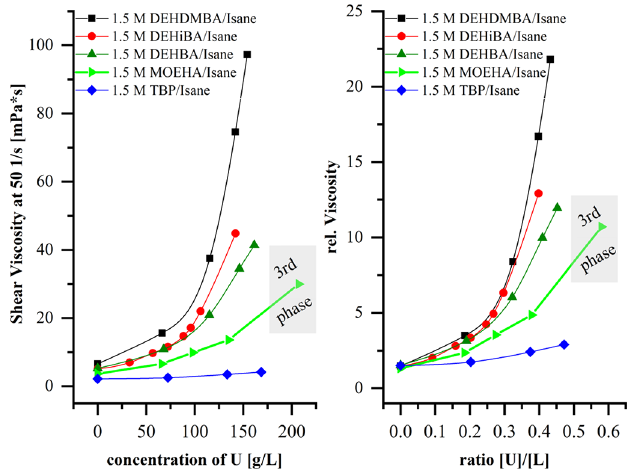
Fig. 4. Viscosity increase due to increasing uranyl concentration in the organic phase for different extractants at 25 ° C. Left: apparent viscosity at a shear rate of 50 1/s. Right: relative viscosity normalized by the viscosity of the non-contacted extractant/diluent mixtures. ■ 1.5M DEHDMBA, 1.5M DEHiBA, 1.5 M DEHBA, 1.5 M MOEHA, 1.5M TBP diluted in Isane IP 175 versus the molar ratio